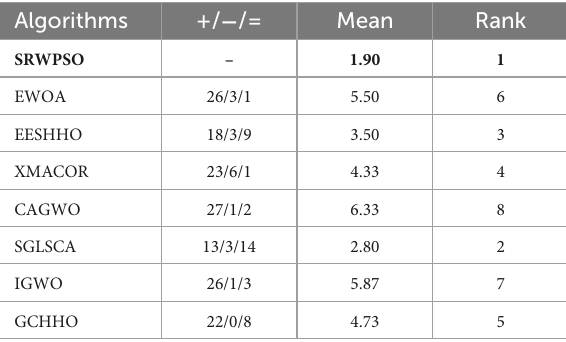
TABLE 9 The results of the Wilcoxon signed-rank test of SRWPSO with new peer variants.